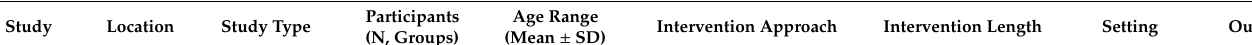
Table 1. Main characteristics of studies included in the present